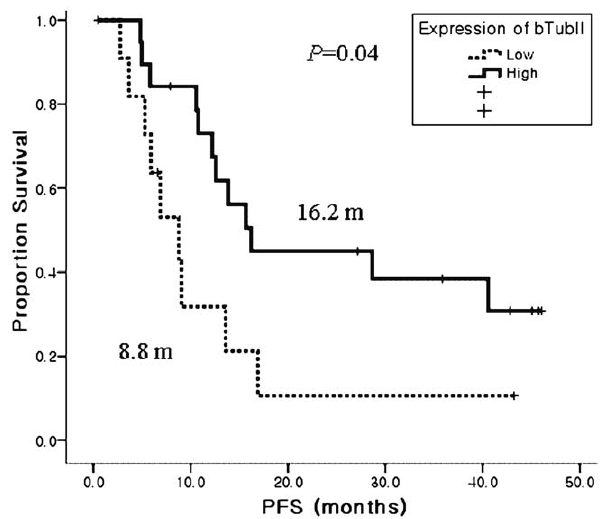
Figure 3. Kaplan-Meier curves comparing PFS according to expression of class III beta tubulin. The patients with high expression of bTubIII tumors had significant longer PFS compared with those with low-expression tumors (16.2 months vs. 8.2 months, p=0.004).